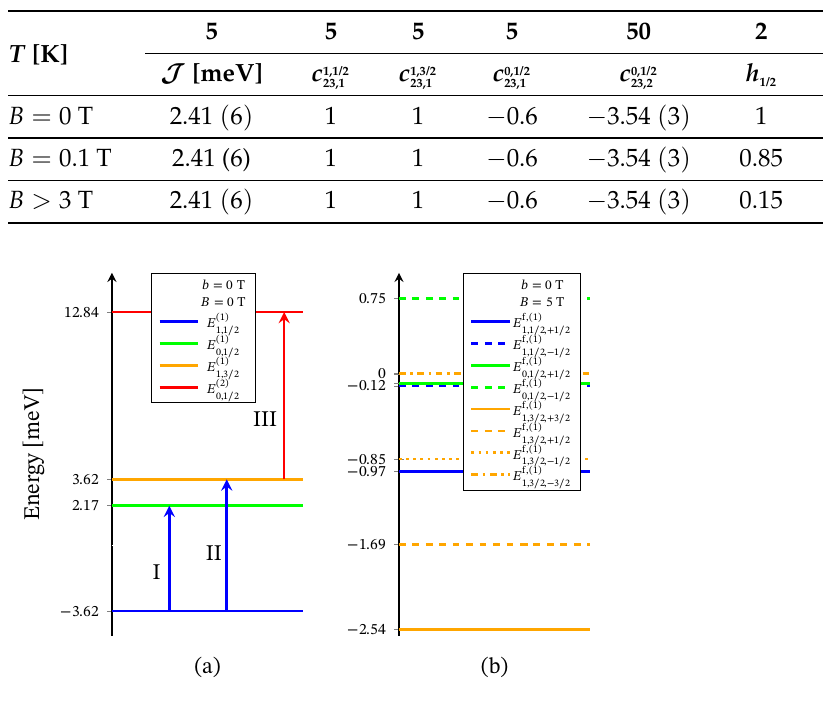
Figure 2. Effective energy spectrum of the polyanion [Er(W 5 O 18 ) 2 ] 9 − obtained with the aid of Hamiltonian (1), ( a ) in the absence of external magnetic field and ( b ) with applied field. The blue and red arrows show the ground state and the high-temperature magnetic excitation energies, respectively, see Figure